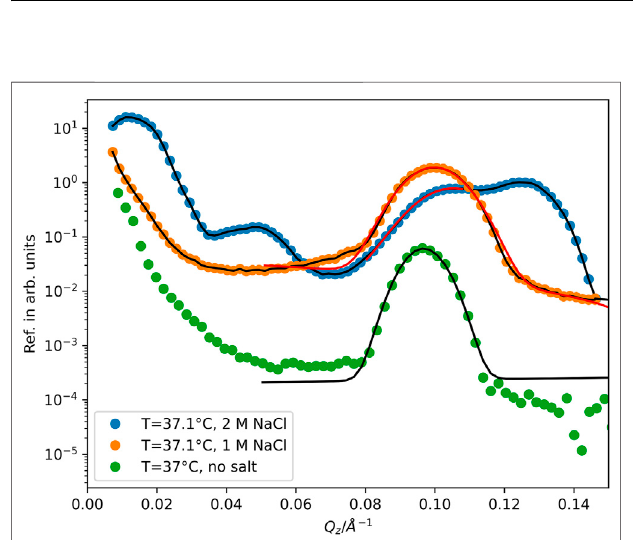
FIGURE 3 | Re fl ectometry data of SoyPC samples with 1 M (left panel) and 2 M (right panel) NaCl in the D 2 O solvent. The black lines represent fi ts obtained by inverse FFT analysis, while the red lines represent Gaussian fi ts to determine the correct peak positions. The curves are shifted along the intensity axis for clarity of the representation.